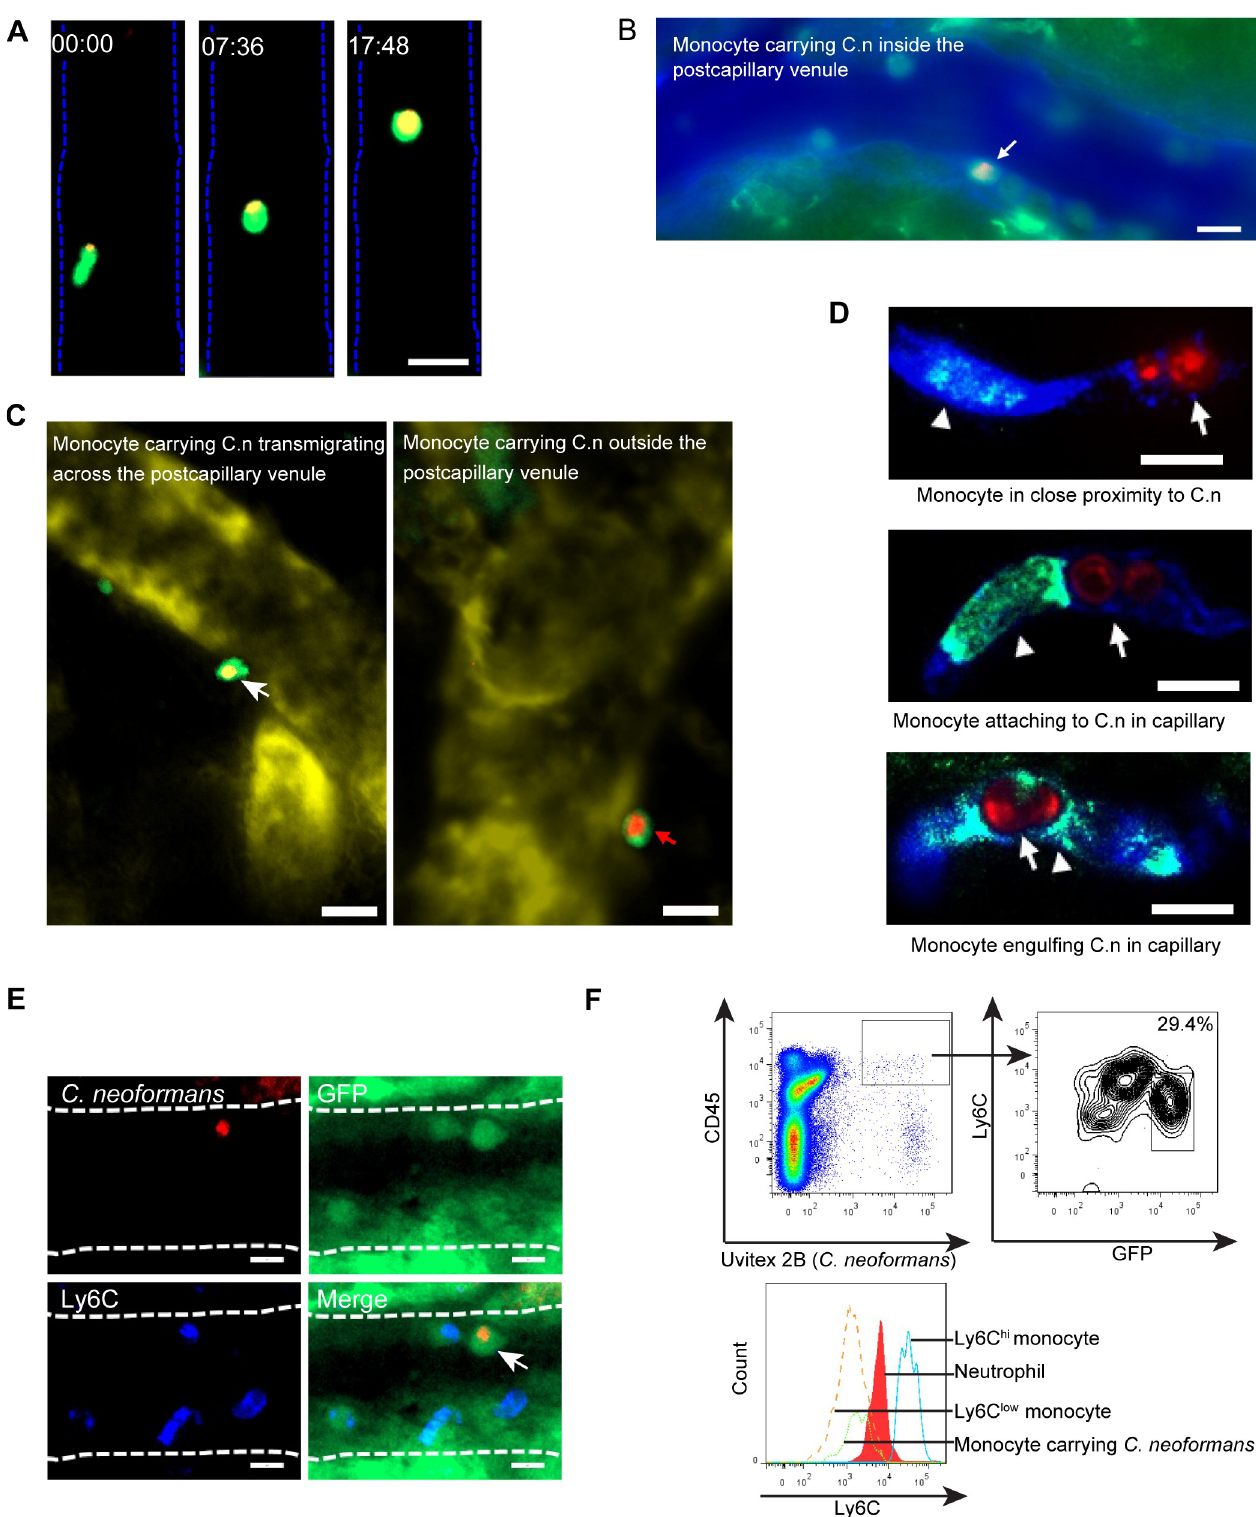
Fig 6. Ly6C low monocytes engulf C . neoformans and carry the organism as they crawl on and adhere to the vessel wall and migrate to the brain parenchyma. (A) A series of IVM representative images showing that a GFP + monocyte (green) carrying an ingested C . neoformans (red) was crawling on the luminal side of a postcapillary venule in the brain of infected CX3CR1 gfp/+ mice. IVM was performed on the brain of mice 18 h after infection with 20x10 6 C .